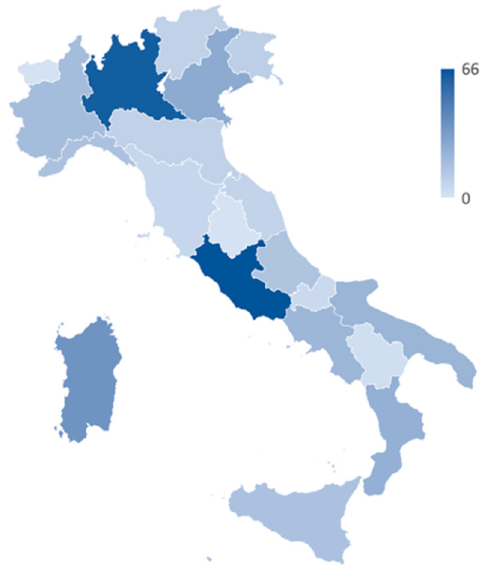
Figure 1. Distribution of the included pharmacies over the Italian territory. Table 1. Characteristics of the population.